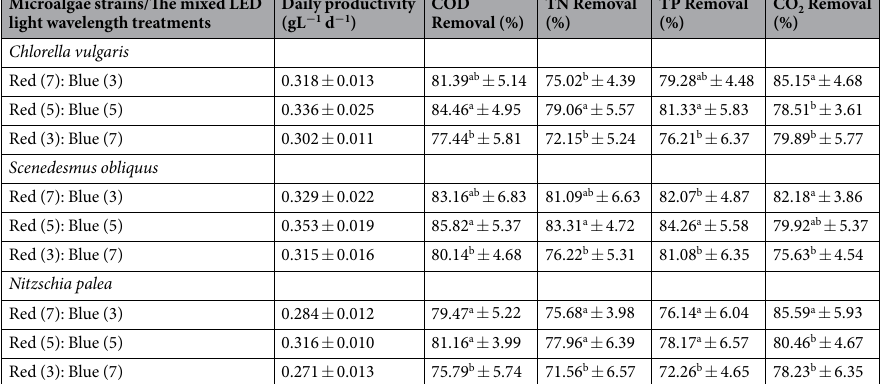
Table 4. Mean values ± SD of daily productivity, as well as the removal efficiency of biogas slurry nutrients and CO 2 at various light wavelength treatments under cultures 2 for the three selected microalgae strains. Note: Values with different superscript letters in the same microalgae strain indicate a significant difference at P < 0.05 according to Duncan’s multiple range